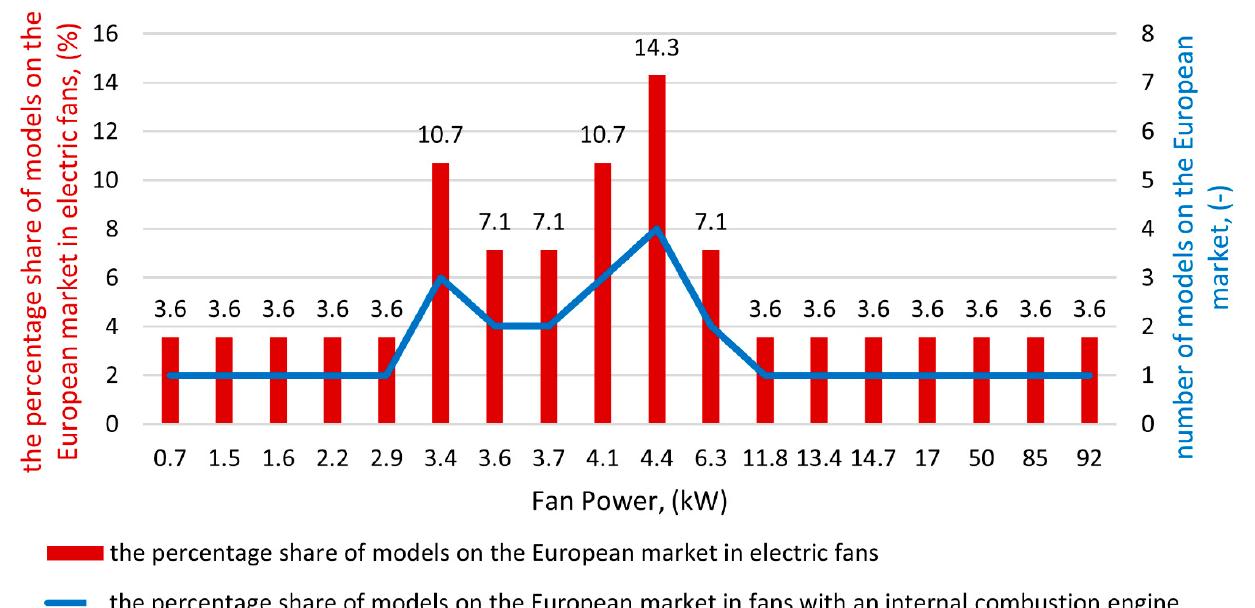
Figure 1. Electric fans on the European market.